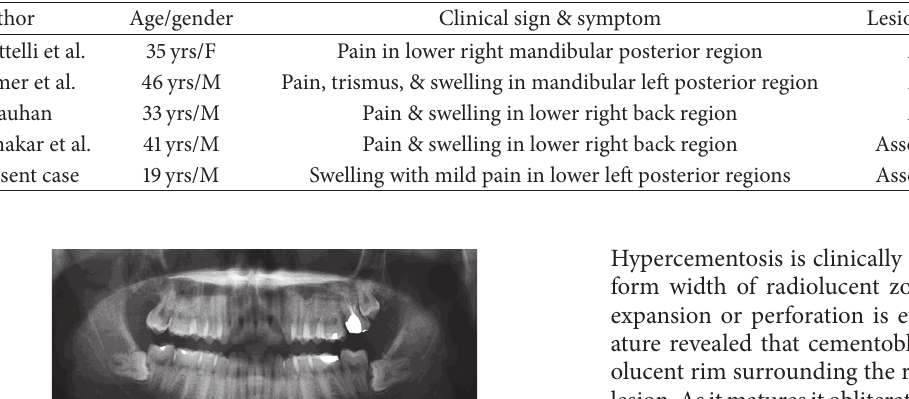
Table 1: Literature review of previous report cases of cementoblastoma associated with impacted teeth.